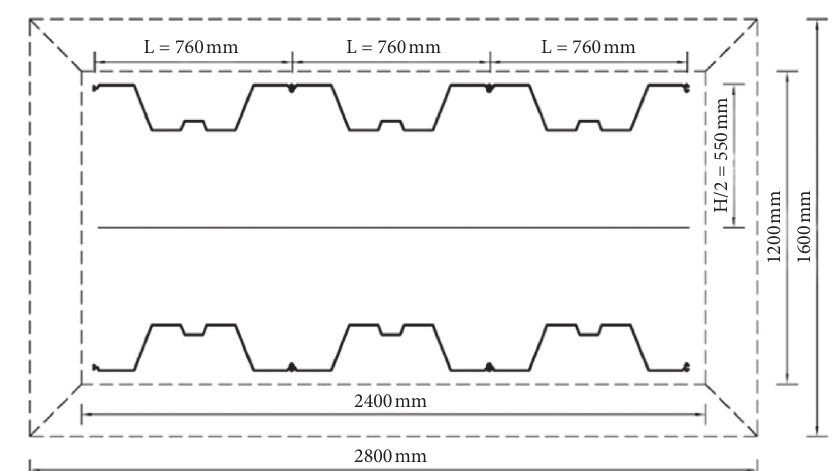
Figure 7: Layout of the piles for Test